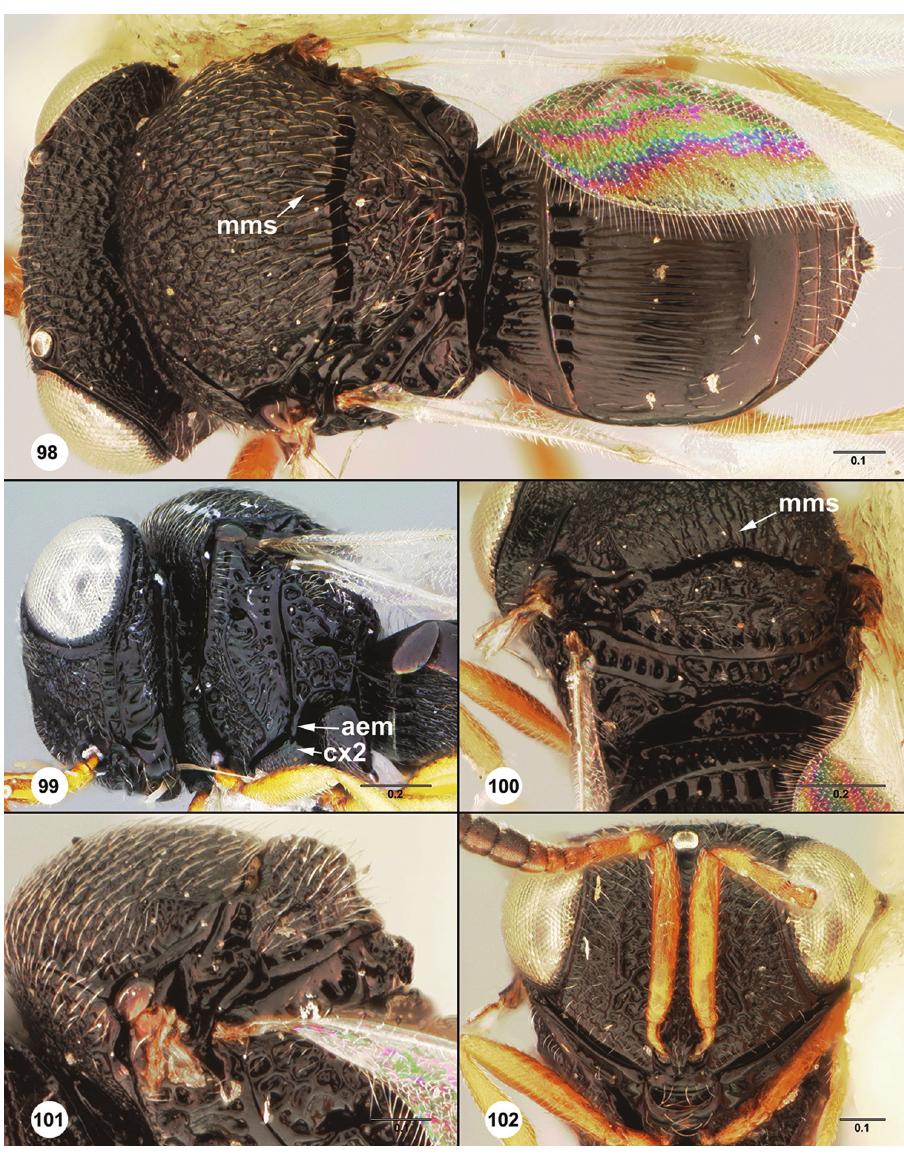
dorsal view 99 female (OSUC 523953), head and mesosoma, ventrolateral view 100 female holotype (USNMENT00989065), mesosoma, posterodorsal view 101 female holotype (USNMENT00989065), dorsal mesosoma, lateral view 102 female holotype (USNMENT00989065), head, anterior view. Scale bars in millimeters.